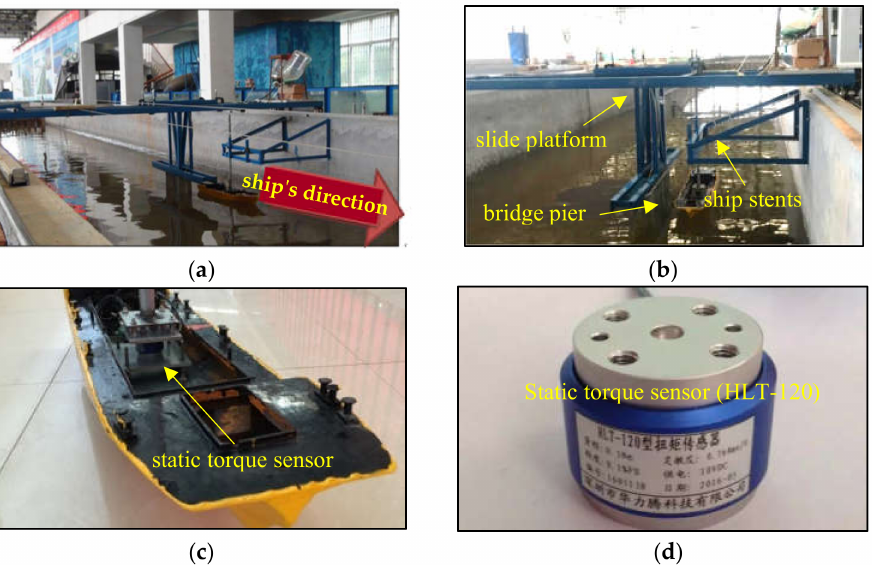
Figure 12. Physical model test site and key equipment: ( a ) Layout; ( b ) Layout; ( c ) Ship model; ( d ) Static torque